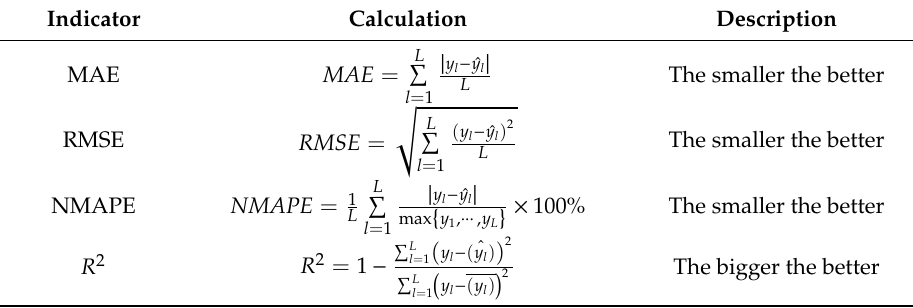
Table 3. Performance evaluation metrics and the corresponding definitions.